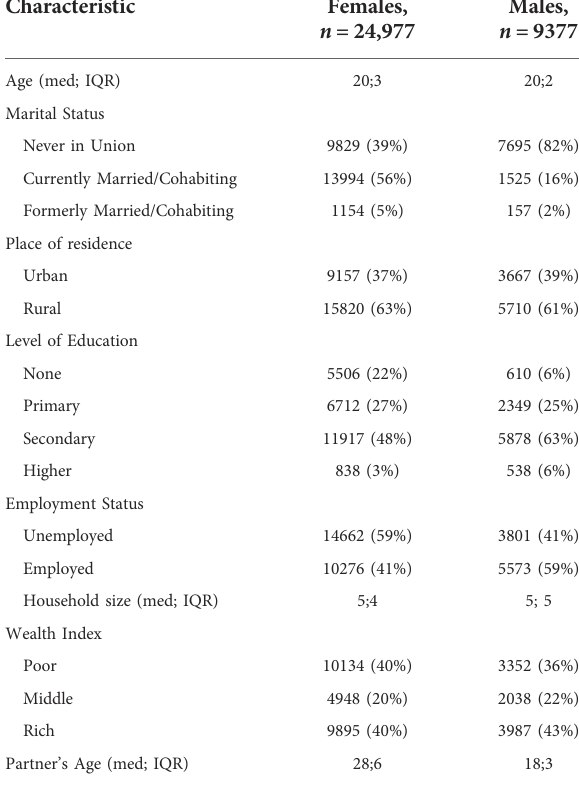
TABLE 2 Sample characteristics by